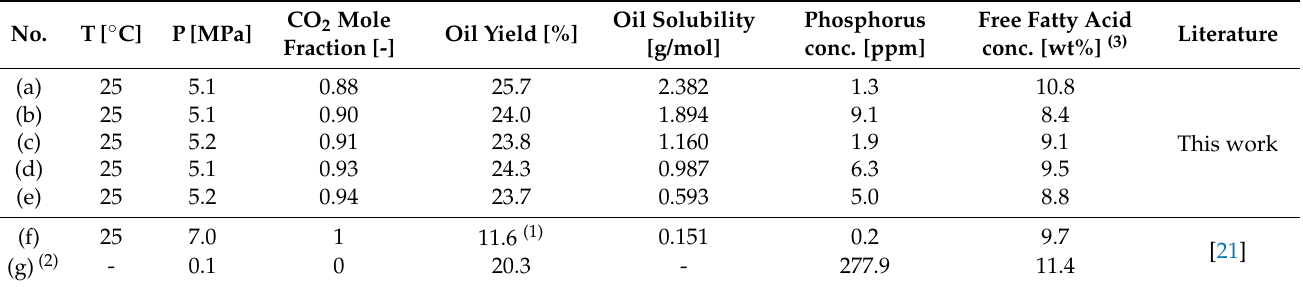
Figure 2. Binary vapor-liquid equilibrium diagram of the CO 2 -hexane system at 25 ◦ C over various experimental points. The symbols (a)–(e) represent the numbers in Table 1. The blue circles show the previous experimental results [21]. Table 1. Extraction conditions and results of rice bran oil using (a–e) CO 2 -expanded hexane, (f) liquid CO 2 , and (g)